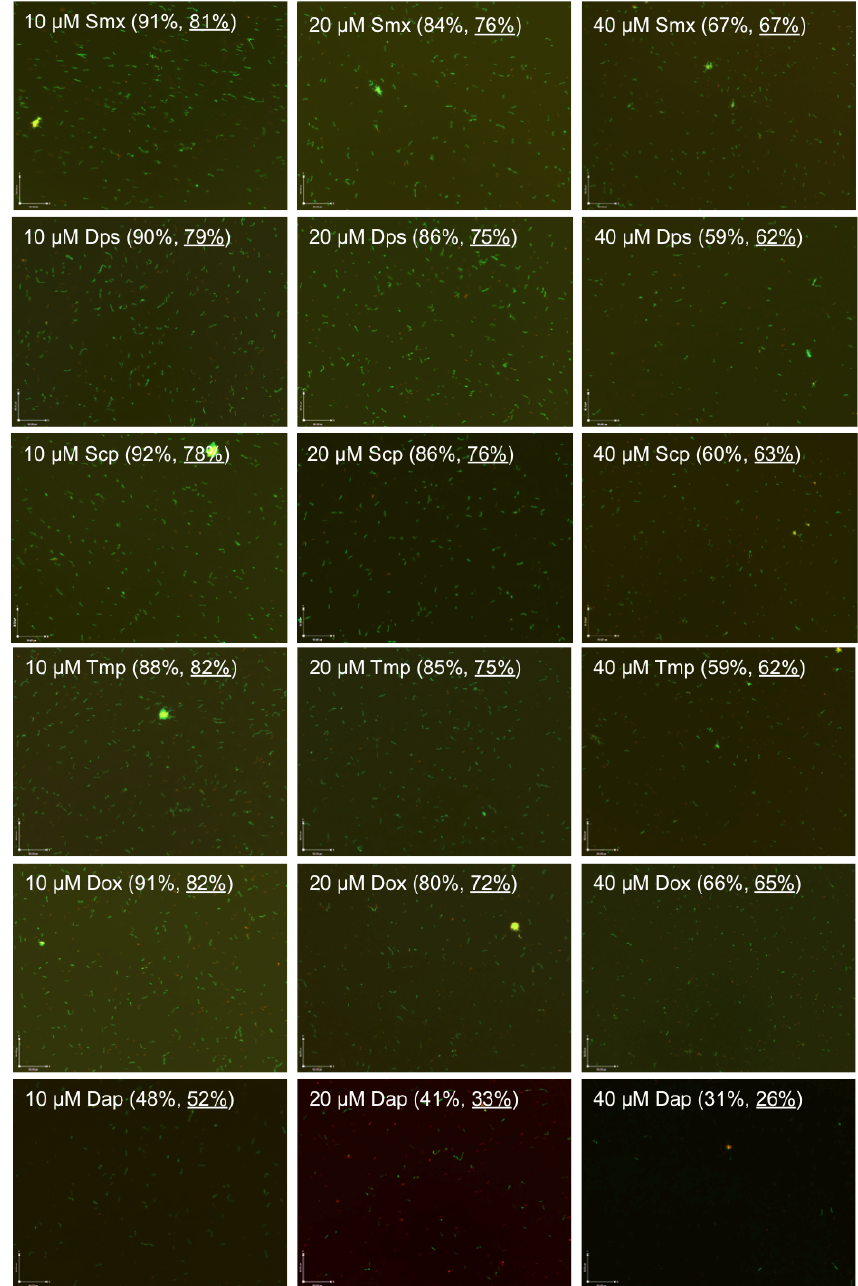
Figure 1. Comparison of anti-persister activity of sulfamethoxazole, dapsone, sulfachlorpyridazine and trimethoprim with doxycycline and daptomycin as controls. A seven-day-old B. burgdorferi stationary phase culture containing aggregated microcolonies was incubated for seven days with sulfamethoxazole (Smx), dapsone (Dps), sulfachlorpyridazine (Scp), trimethoprim (Tmp), doxycycline (Dox) and daptomycin (Dap) at the same drug concentrations of 10, 20 or 40 µ M, respectively, followed by viability assessment using the SYBR Green I/PI assay. Representative images were taken using epifluorescence microscopy at 100 × magnification. The calculated percentage and direct counting percentage (underlined) of residual viable cells are shown in brackets. The green cells stained by SYBR Green I dye indicate live cells while the red cells stained by PI dye indicate dead cells.